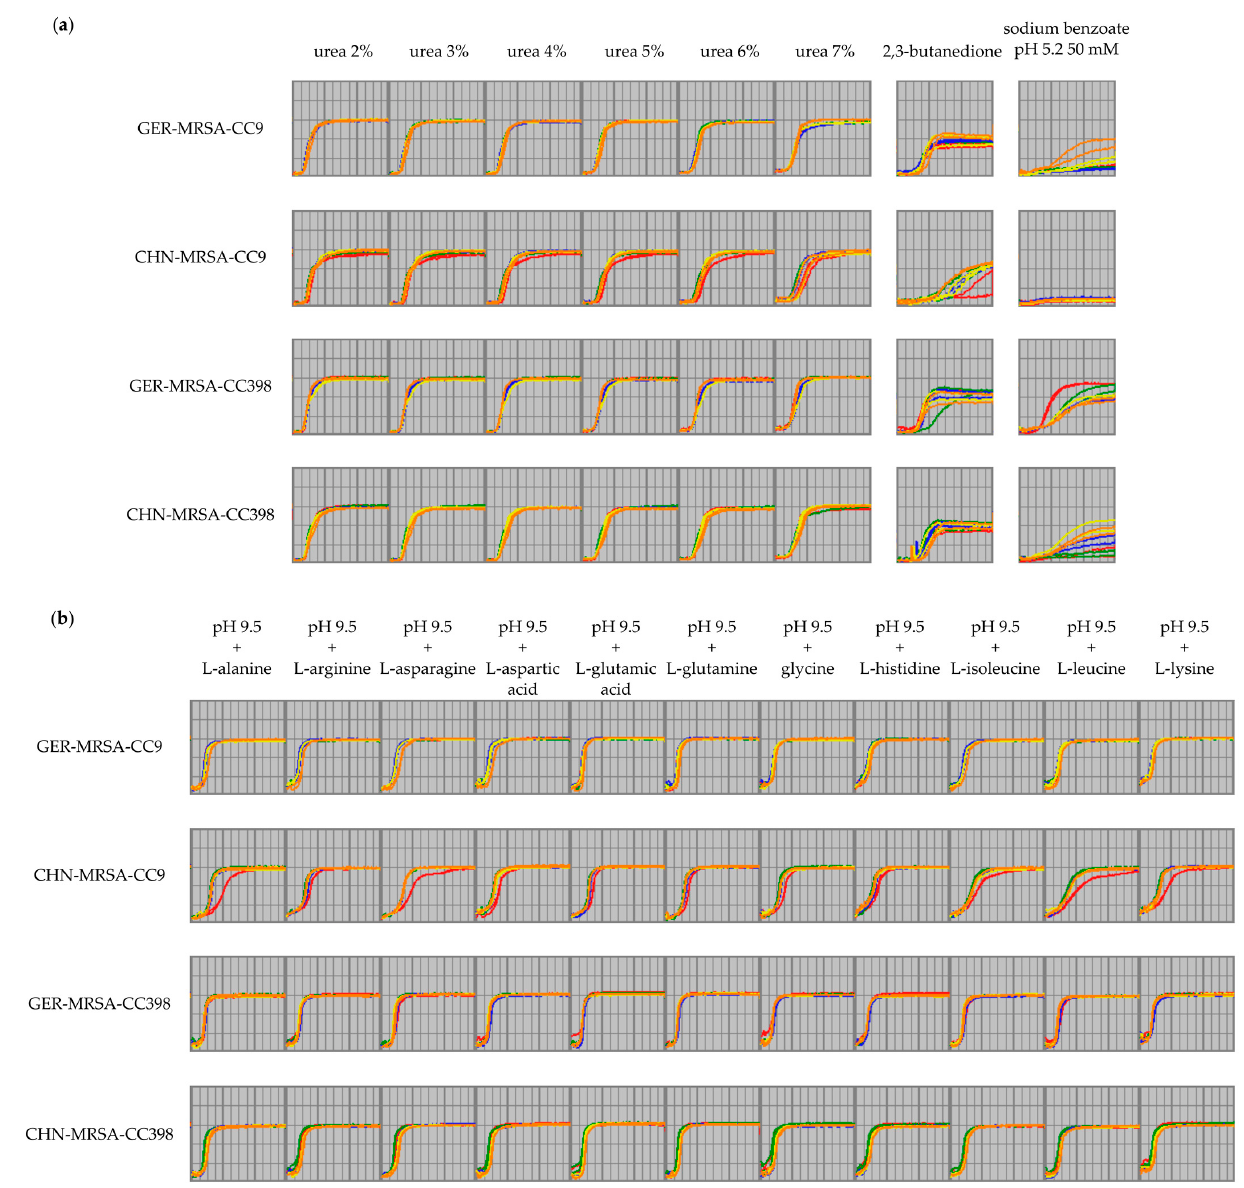
Figure 5. Curves displaying cellular respiration of the four isolate groups over an incubation period of 24 h including two test runs. The isolates within each group are indicated in different colors. ( a